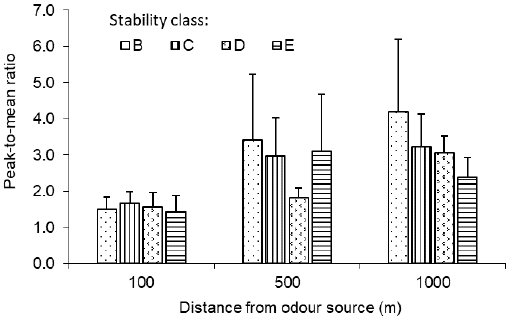
Figure 10. Measured PMR_OI for 30 min averaging time under di ff erent stability classes (B, C, D, and E) at 100, 500, and 1000 m from the odour source.